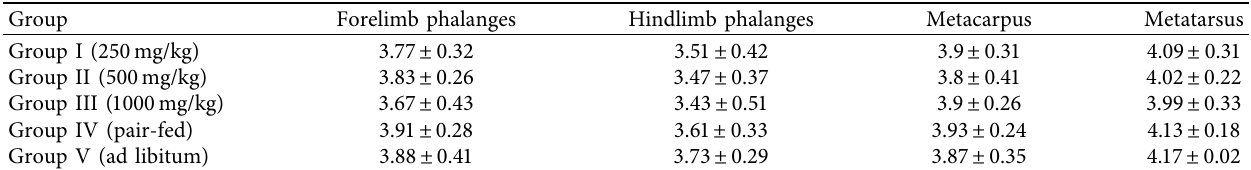
Table 11: Number of ossification centers in the appendicular skeleton of rat fetuses from experimental groups treated with the 80% ethanol fruit extract of Embelia schimperi .